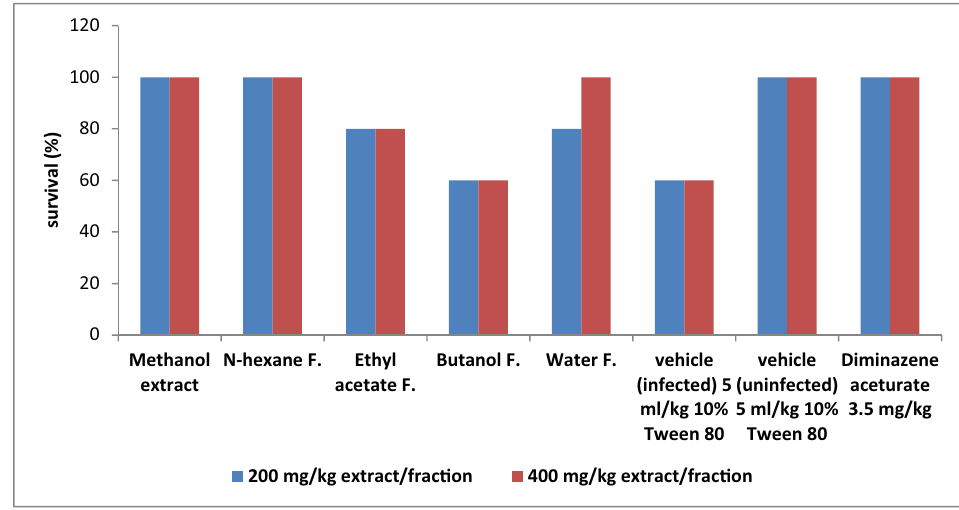
Figure 2: E ff ect of the extract and fractions on percentage survival of T. brucei brucei - infected